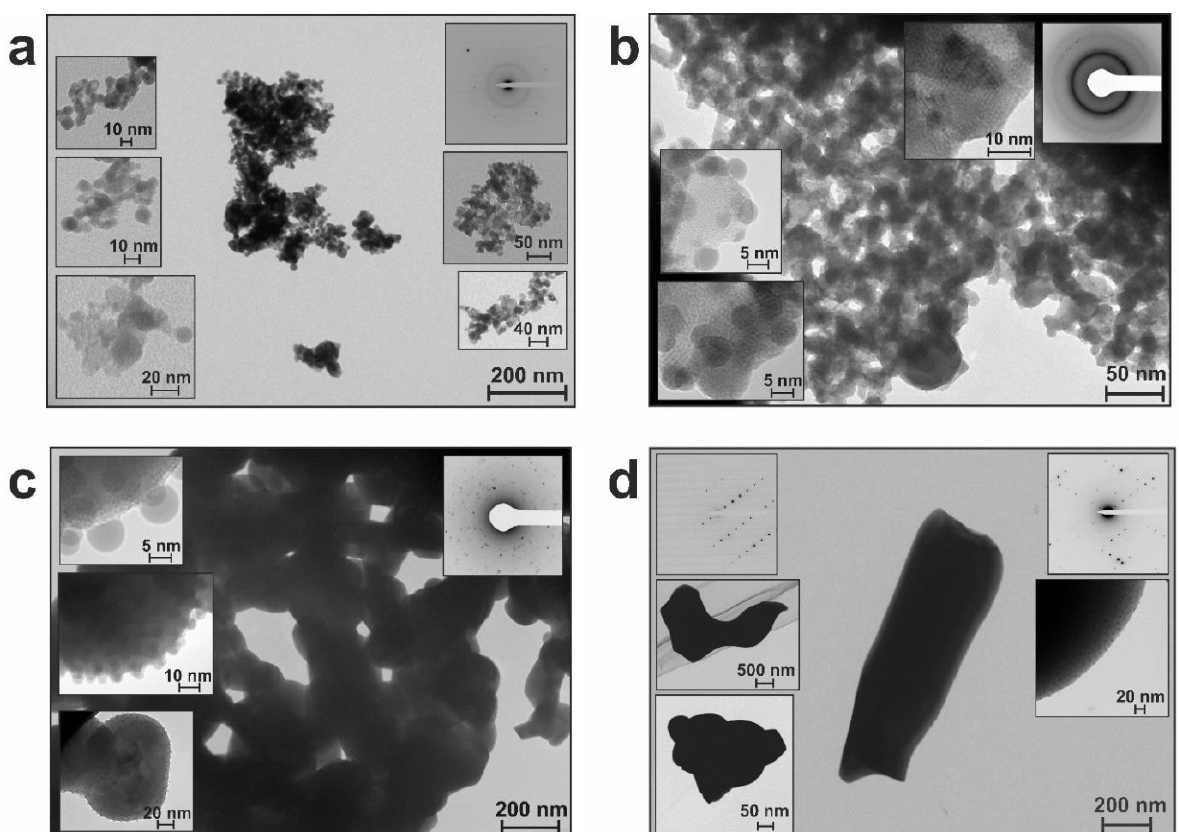
Figure 9. TEM images of selected samples from the BSO group: ( a ) BSO_3, ( b ) BSO_4, ( c ) BSO_6, and ( d ) BSO_8 annealed at 300, 400, 600 and 800 °C, respectively.